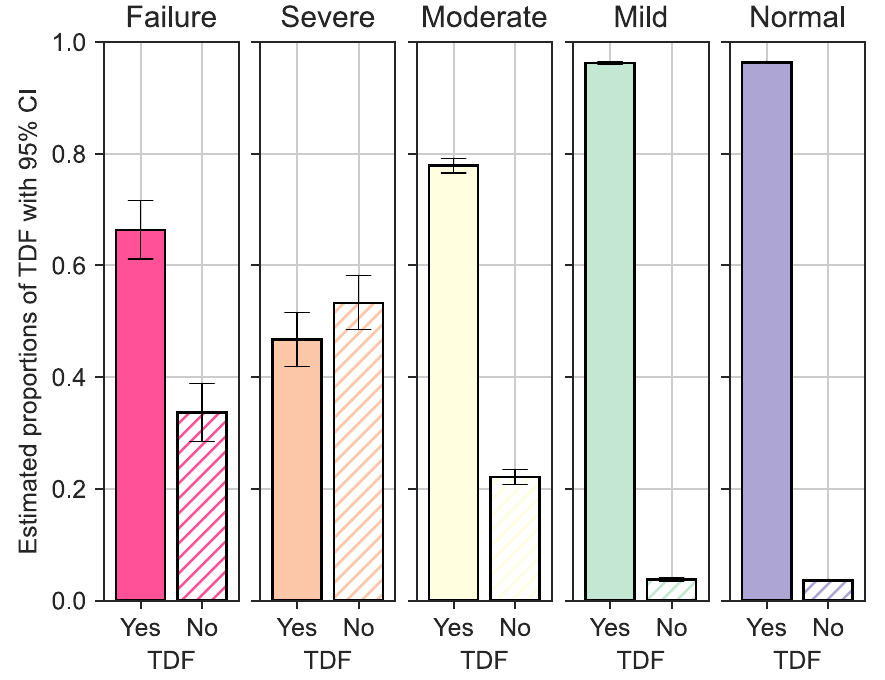
Fig 2. Proportion TDF containing regimen by eGFR (CKD-EPI) category.